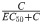
Schematic illustration of the sensitivity of D1 and D2 receptors to the changes in dopamine (DA) level.Black and grey curves show how the probability of D1 and D2 receptor occupancy depends on DA concentration in a biophysical model of [36]. They assumed that receptor occupancy depends on DA concentration C as CEC50+C, where EC50 is the receptor affinity, which was taken as 1μM and 10nM for D1 and D2 receptors respectively, based on [38]. Dashed line indicates baseline DA concentration C = 60nM suggested by simulations in [37]. Vertical arrows indicate how much binding probability changes due to changes in DA concentration, shown by horizontal arrows.